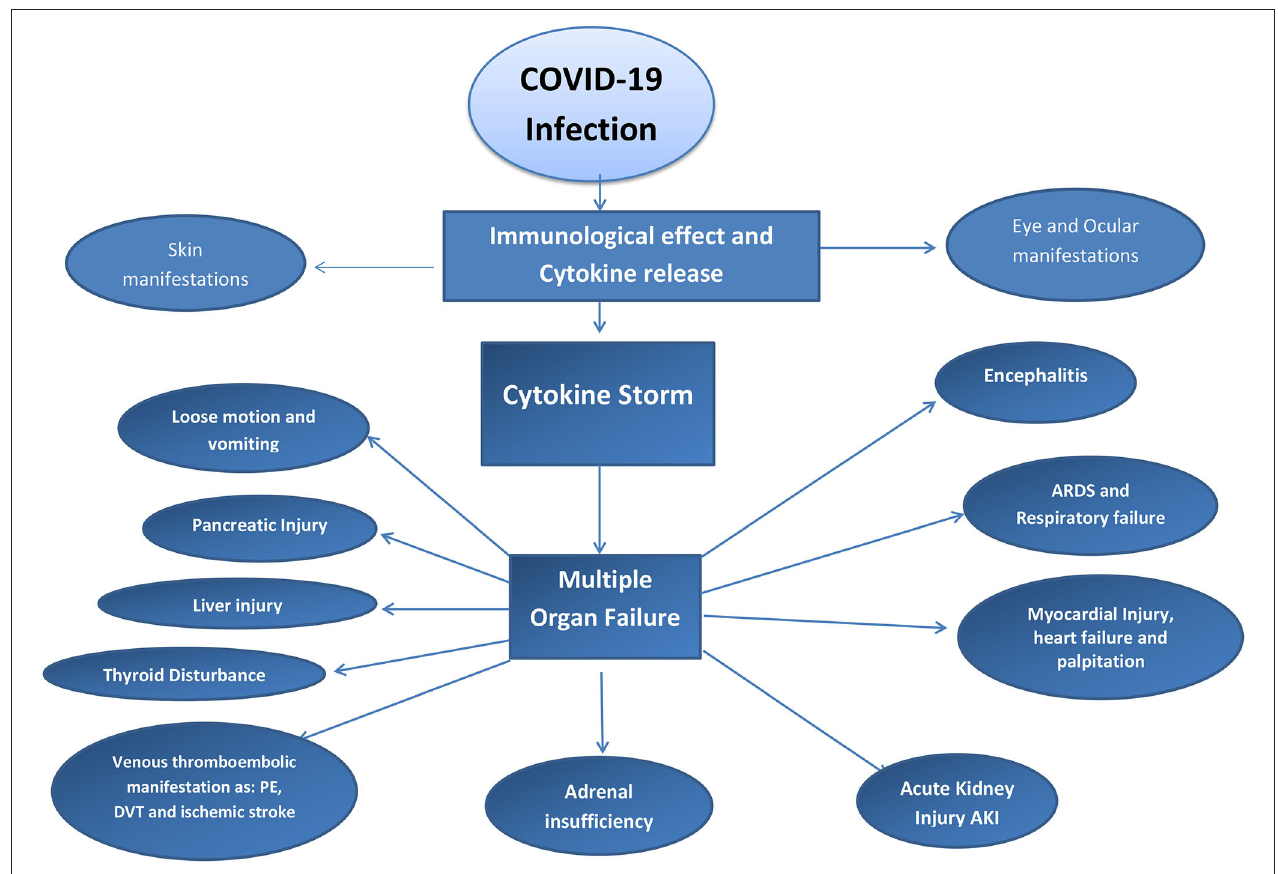
FIGURE 3 | Diagram to explain Cytokine storm effect in COVID-19